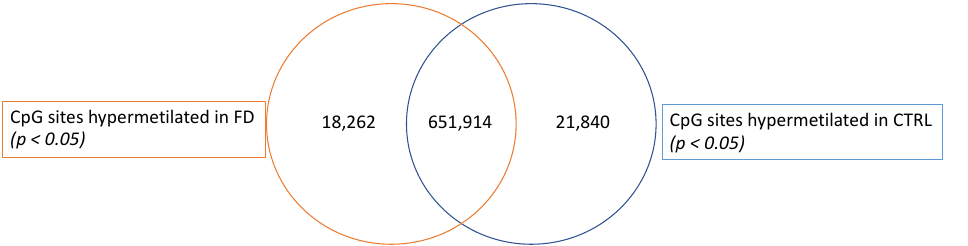
Figure 3. Venn diagram showing the statistically significant differentially methylated CpG sites in the FD and CTRL groups.